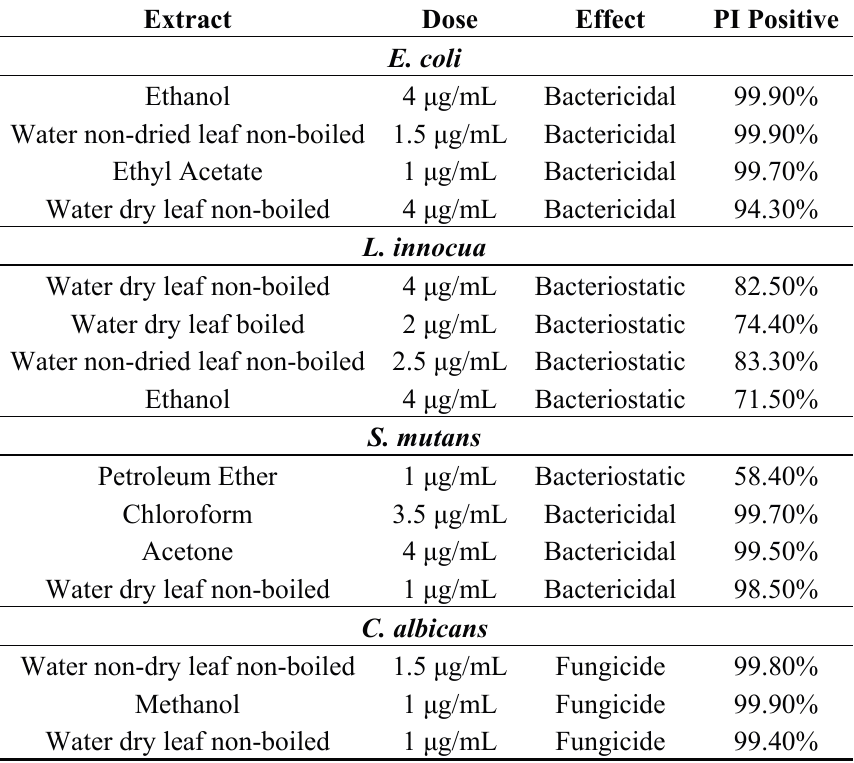
Table 1. Flow Cytometry